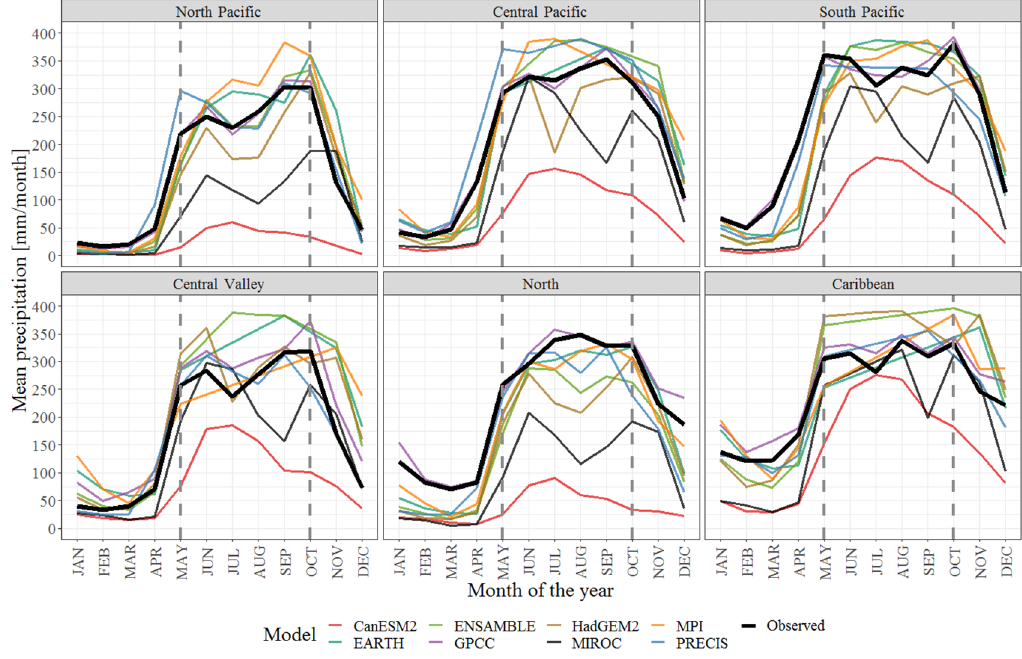
Figure 4. Spatially-averaged observed and uncorrected GCM-RCM annual cycle of precipitation during the period 1951–1995 for all climatic regions of Costa Rica. the period 1951–1995 for all climatic regions of Costa